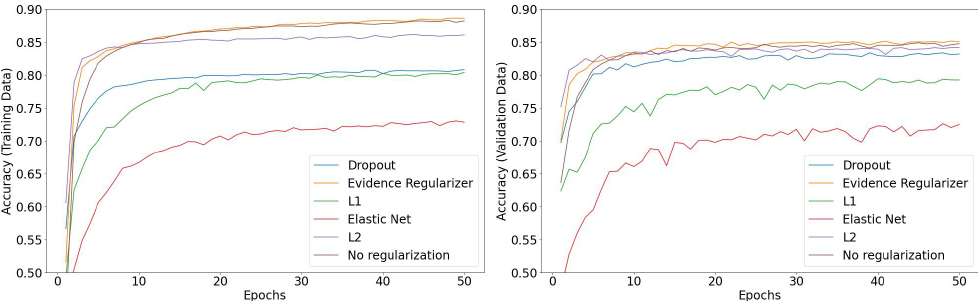
Figure 2. Training ( left ) and validation ( right ) accuracy for different regularization approaches.